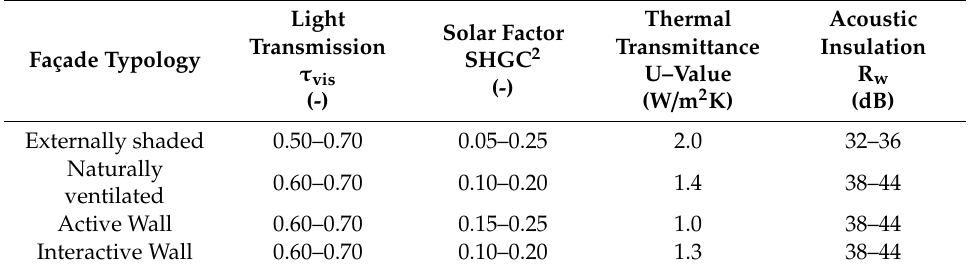
Table 2. Indicative characteristics of di ff erent facade typology